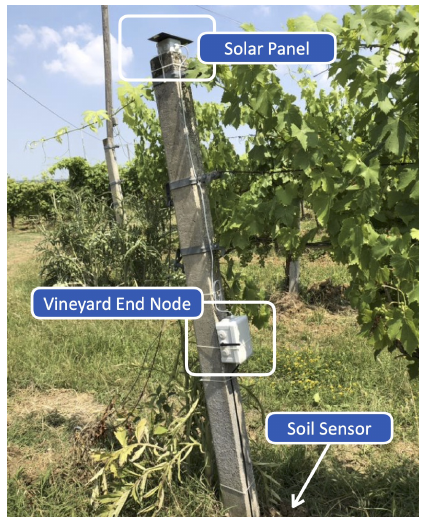
Figure 7. A vineyard module EN (SN-V1) installed in the